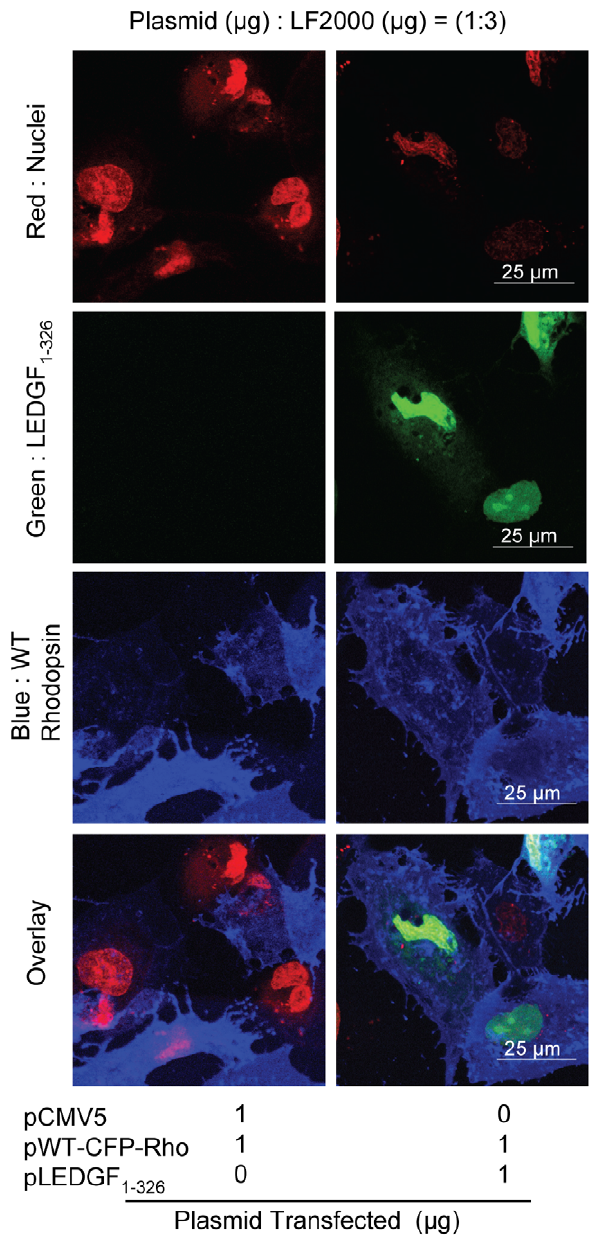
Figure 6. Diffuse fluorescent signal of WT rhodopsin in RPE cells. Cells were fixed with 4% buffered formalin, permeabilized with 0.2% Triton X-100 and treated with RNase. The nucleus was then stained with TO-PRO-3 iodide. WT rhodopsin visualization was done using Zeiss LSM 510 NLO laser scanning confocal microscope with 63x optical zoom. The excitation-emission wavelengths used for CFP, GFP, and TO-PRO-3 iodide were 800 nm (2-photon excitation)-435/485, 488– 505 (long pass), 633–650/710 nm, respectively. Images were analyzed using Zen 2000 light edition. Data presents representative images from one of the three independent